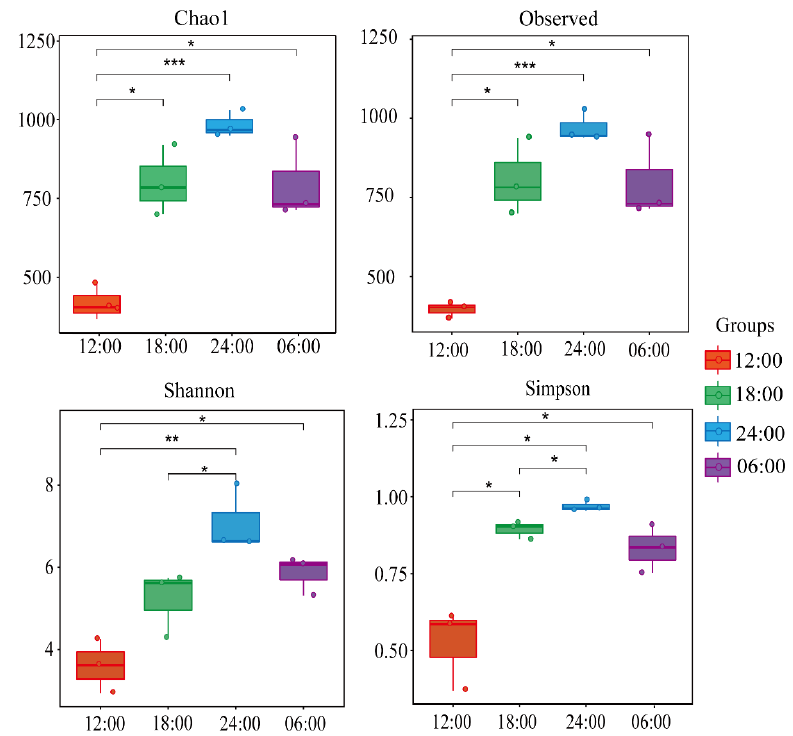
Figure 3. Alpha-diversity indices of the gut bacterial community (Chao1, Observed, Shannon, Simpson. confidence intervals (whiskers). Asterisks indicate statistically significant differences between pairs of values (* p < 0.05, ** p < 0.01, and *** p < 0.001).